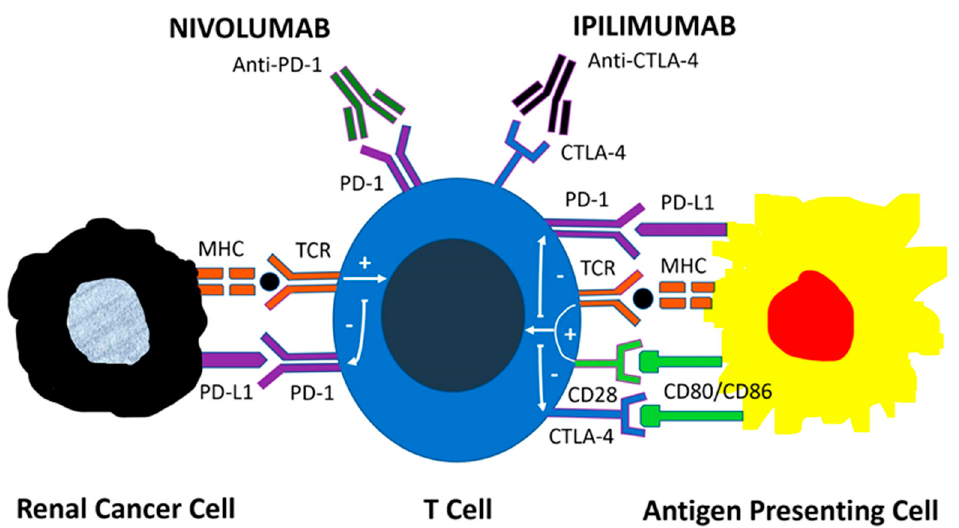
Figure 1. Mechanisms of action of immune checkpoint inhibitors. PD-1 acts as a negative regulator of T-cell activity by binding to PD-L1 on tumor cells and antigen-presenting cells, leading to downstream signaling that inhibits the antitumor T-cell response. CTLA-4 also negatively regulates T-cell activation by binding to B7 ligands CD80 and CD86 on antigen-presenting cells, thus preventing the co-stimulatory interaction between CD28 and B7 ligands. The monoclonal antibodies Nivolumab and Ipilimumab target the immune checkpoint proteins PD-1 and CTLA-4, respectively. Nivolumab blocks the inhibitory signal of the PD1: PD-L1 interaction while Ipilimumab blocks the inhibitory signal of the CTLA-4: B7 interaction.